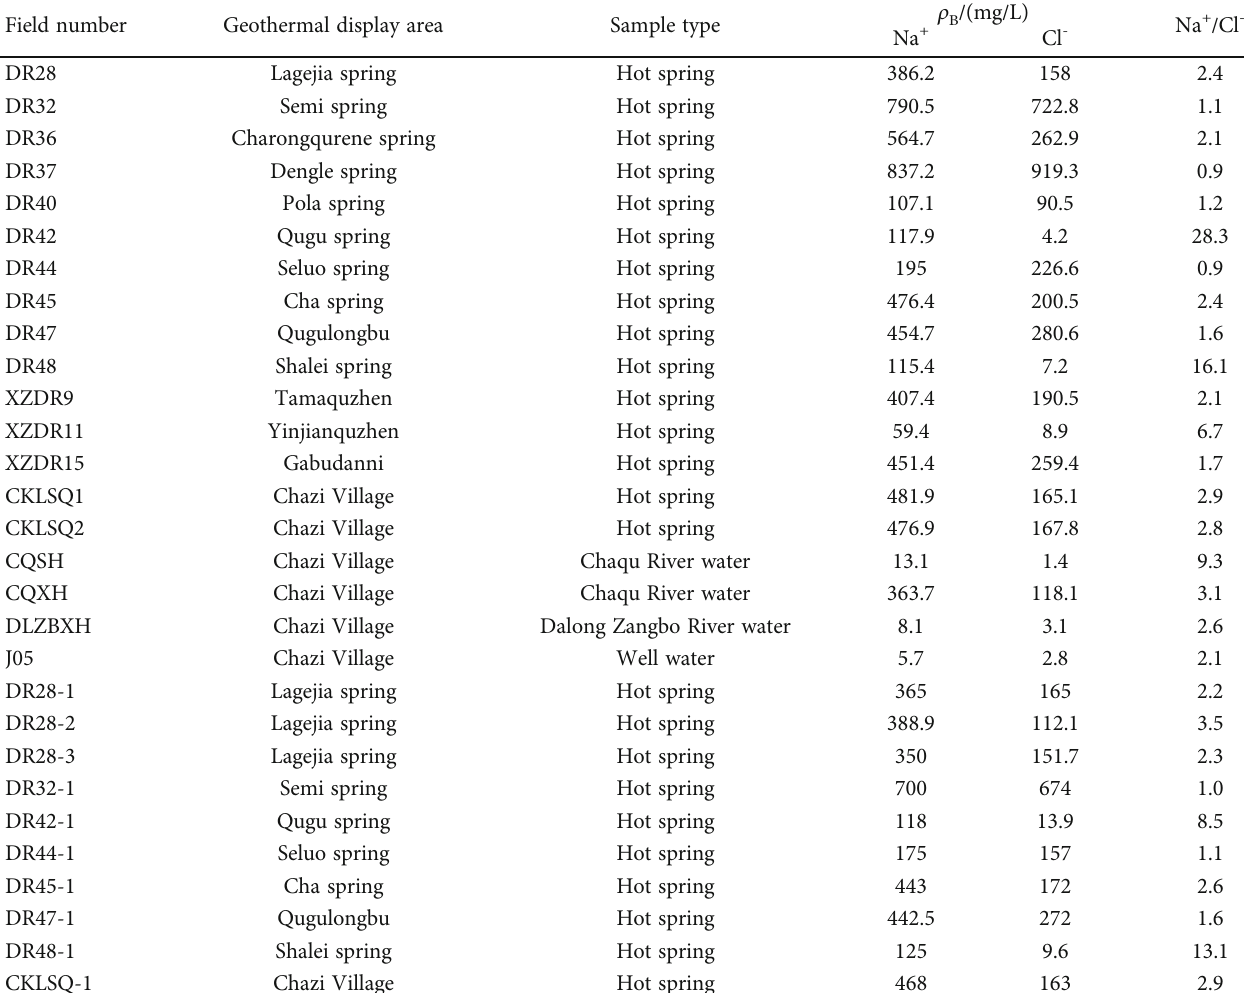
Table 3: Ratios of Na and Cl in the study